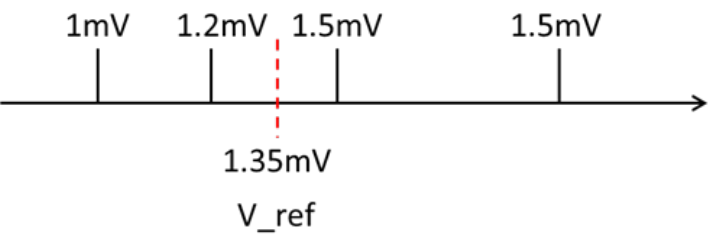
Figure 3. Voltage distribution of majority, where V_ref = 1.35 mV.